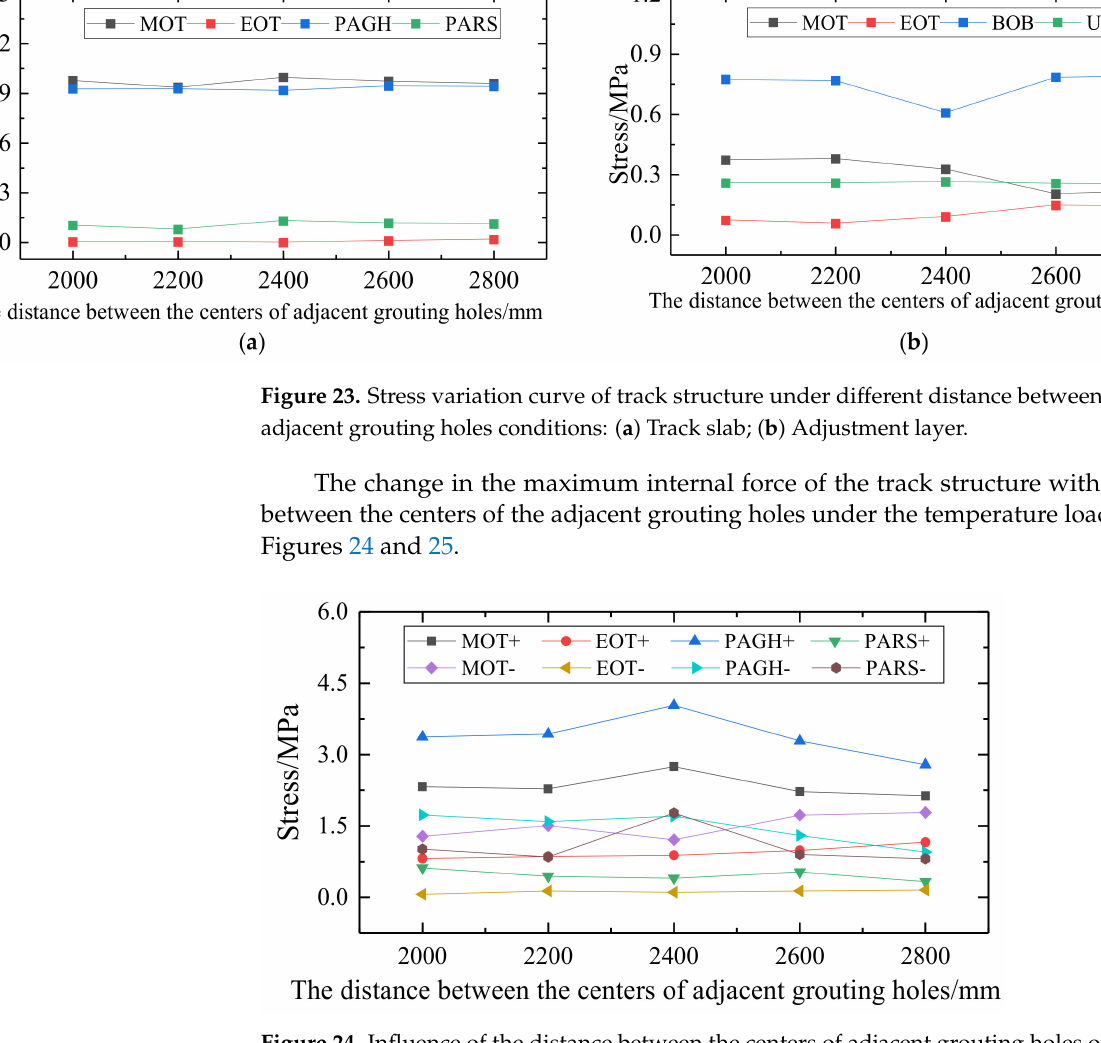
Figure 24. Influence of the distance between the centers of adjacent grouting holes on temperature stress of track slab (In legend identification, “+” means positive temperature gradient; “ − ” means negative temperature